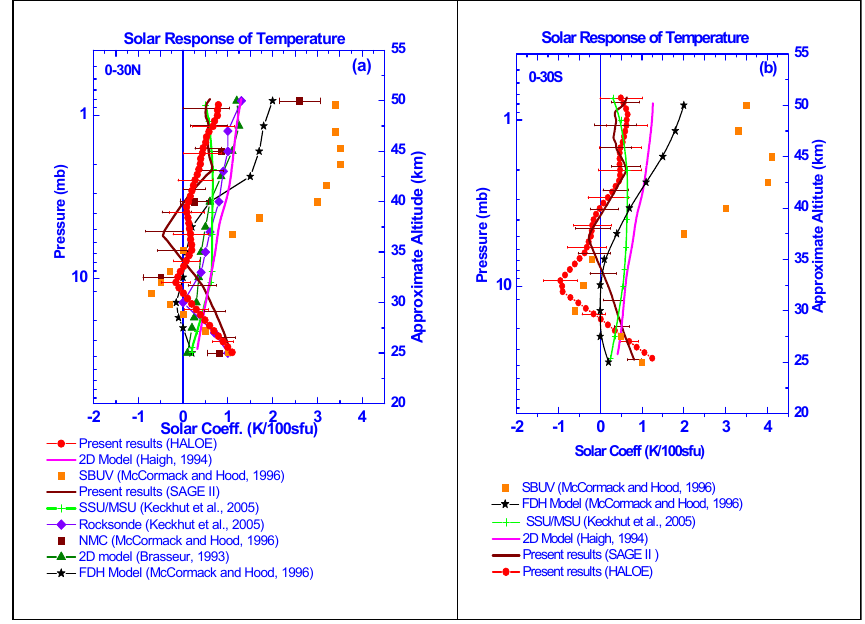
Fig. 5. The vertical distribution of the annual mean solar coefficient of temperature (K/100 sfu) as obtained in the present study (– HALOE profile) and ( – SAGE II profile) are compared with Rocketsonde (Keckhut et al., 2005) (- ♦ -), SSU/MSU (Keckhut et al., 2005) (-+-), NMC results (McCormack and Hood, 1996) (–), FDH model results (McCormack and Hood, 1996) (-*-), 2-D model results (Brasseur, 1993) (–) and 2-D model results (Haigh, 1994) ( – ) over (a) 0–30 ◦ N (b) 0–30 ◦ S latitudinal